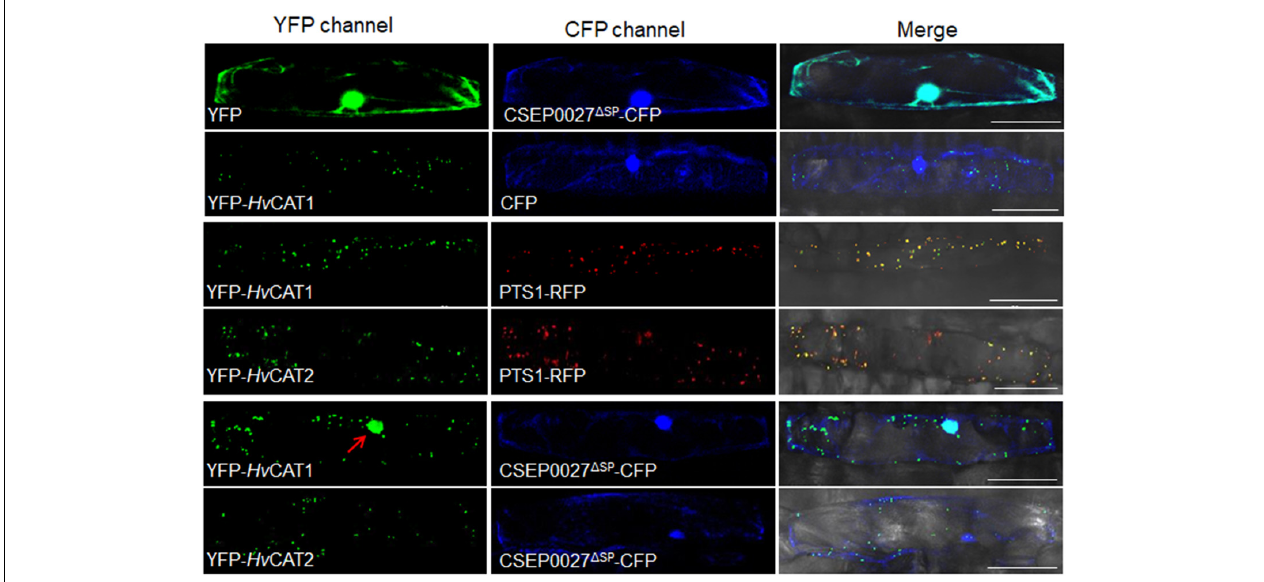
FIGURE 5 | CSEP0027 affects the subcellular localization of Hv CAT1. One-week-old barley leaves (P01) were bombarded with combination of indicated constructs coexpressing YFP- Hv CAT1/PTS1-RFP, YFP- Hv CAT2/PTS1-RFP, YFP- Hv CAT1/CSEP0027-CFP, or YFP- Hv CAT2/CSEP0027-CFP, respectively. Photographs were taken at 2 days after bombardment using a Nikon confocal laser scanning microscope. Bar = 50 µ